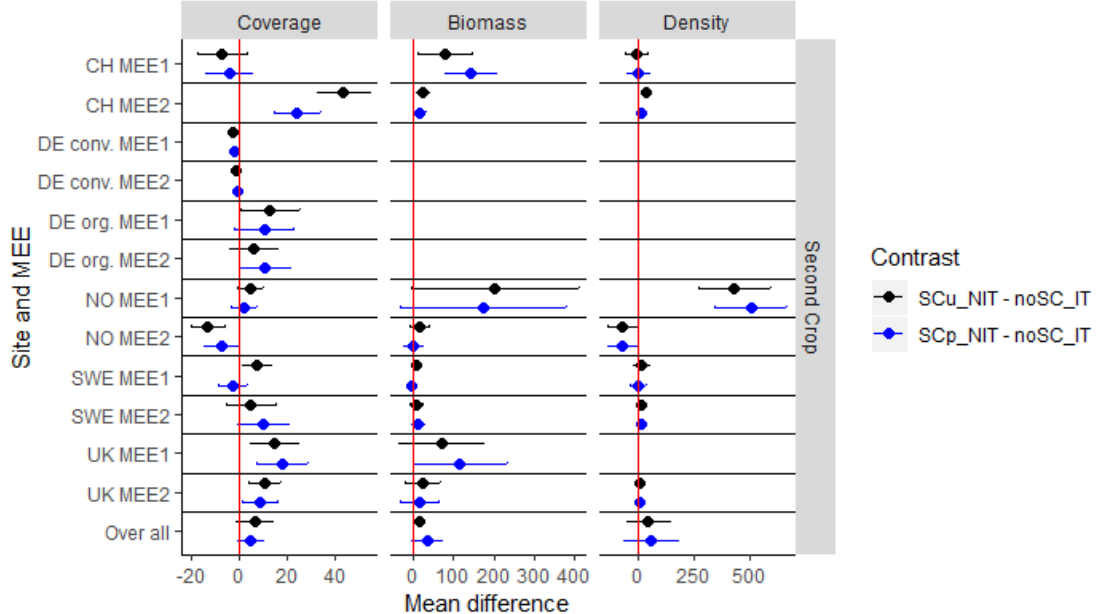
Figure 6. Meta-analysis of the e ff ect of the under-sown subsidiary crops (SCu, black) and subsidiary crops sown post-harvest (SCp, blue) and non-inversion tillage (NIT) as an alternative system SCu_NIT / SCp_NIT) compared to the reference system (no subsidiary crops and inversion tillage; noSC_IT) on the weed abundance in the second crop. Values are given as mean di ff erences. A negative mean di ff erence represents a lower weed abundance in the alternative system and a positive e ff ect size represents a lower weed abundance in the conventional system. The points represent the estimated effect and the lines the corresponding 95% confidence interval. Weed coverage is given in %-ground coverage, biomass in g m − 2 , and density in plants m -2 . (MEE1/MEE2 — first/second round of the multi-environmental